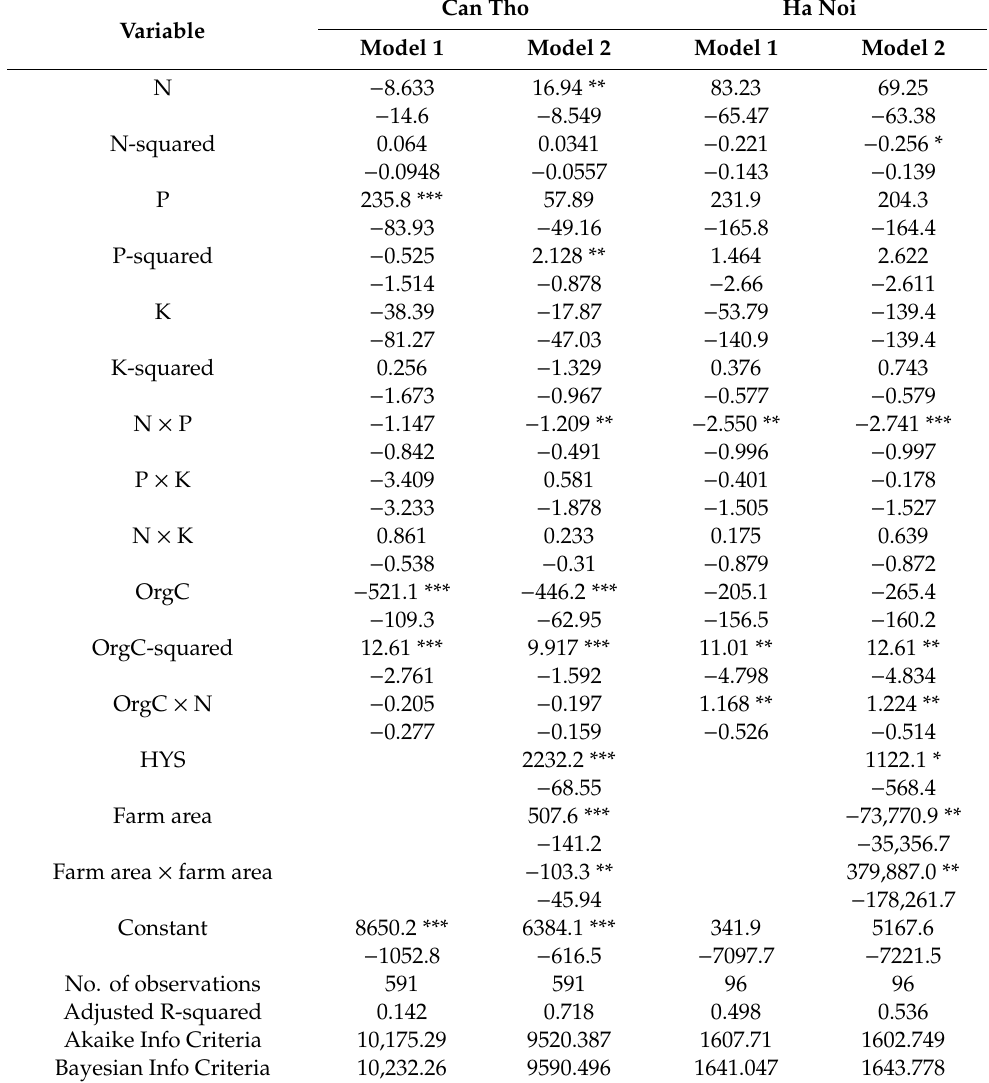
Table 6. Production function estimates using two versions of the quadratic model in